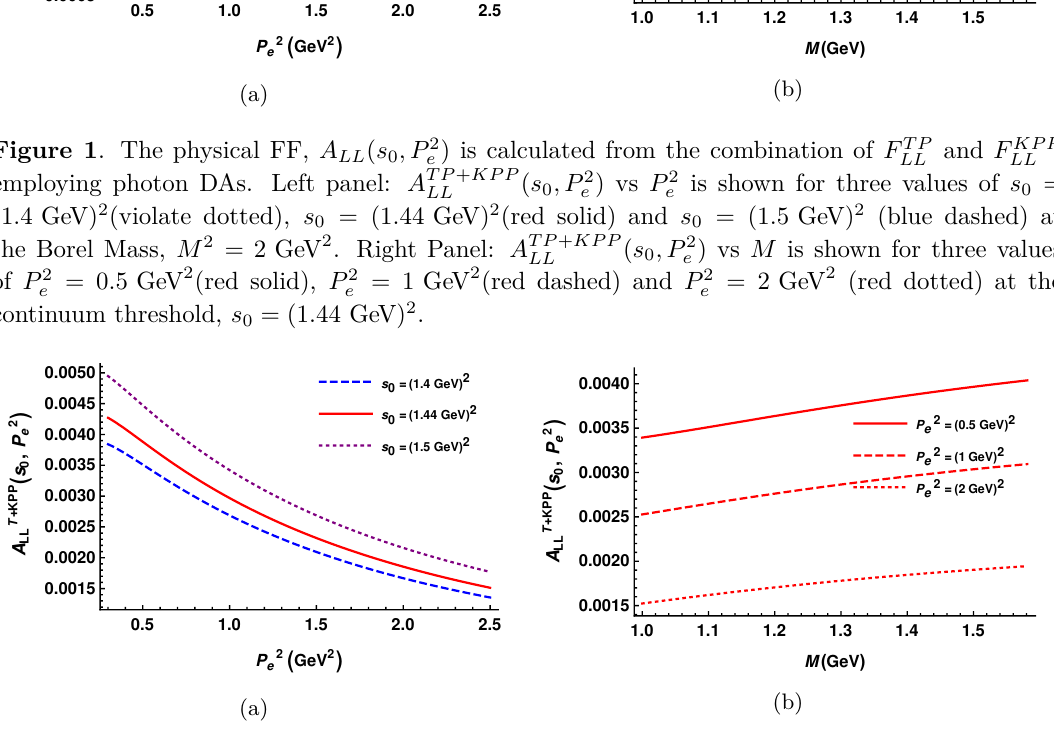
Figure 2 . Same as figure 1 but now with the combinations of F T